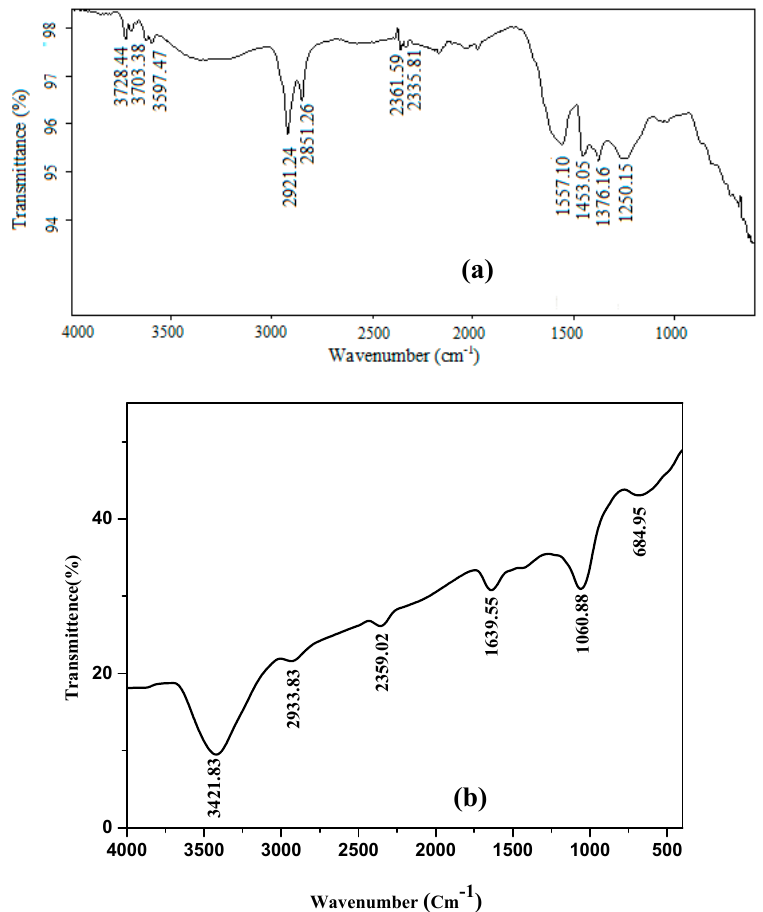
Figure 2. FTIR spectrum of ( a ) El-Maghara mine coal, and ( b ) nano-activated carbon.